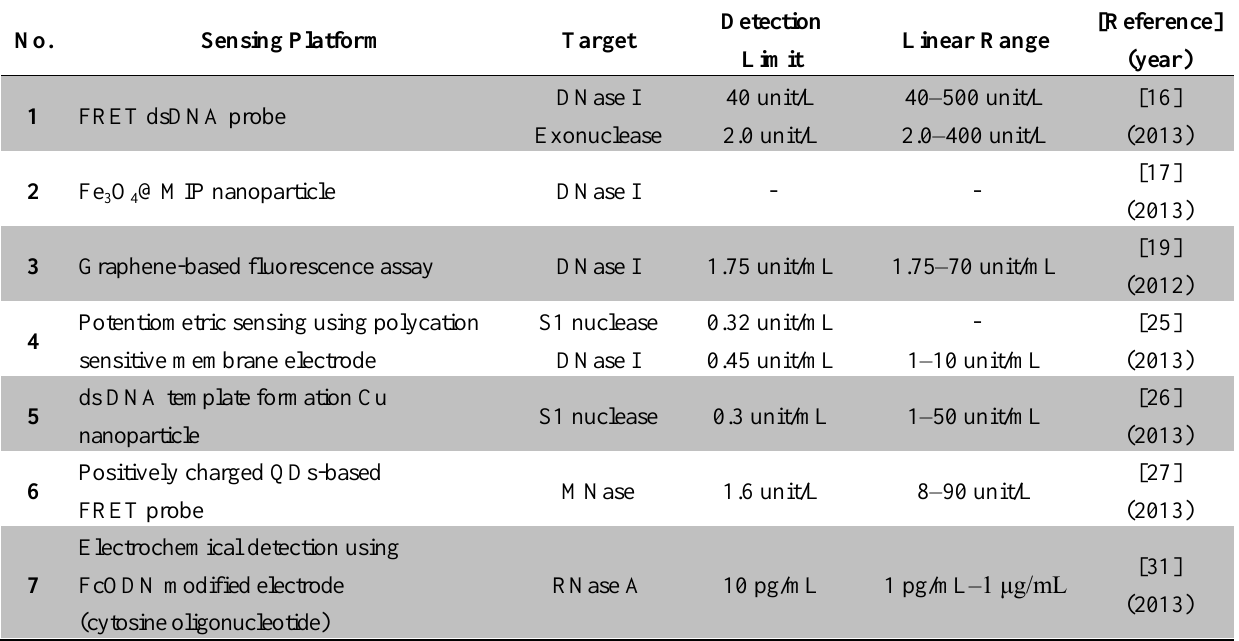
Table 2. Analytical performance in platforms of DNase and RNase detection